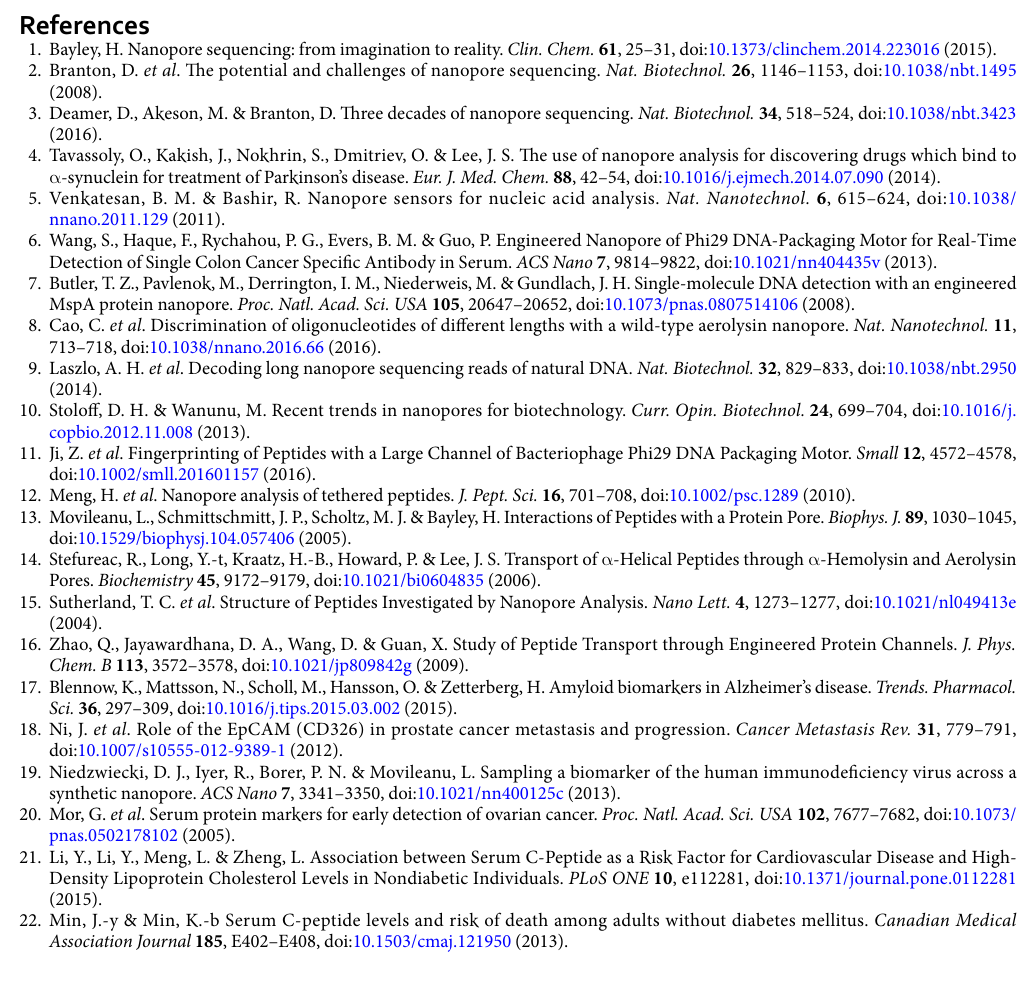
mobile phases consisted of solvent A (5% acetonitrile and 0.1% formic acid in water) and solvent B (0.1% formic acid in acetonitrile). The elution started at 0% B, held at this percentage for 9 minutes, increased to 25% B over 10 minutes, further increased to 60% B over an additional 11 minutes, and then was kept at this percentage for 21 minutes. The LC flow rate was maintained at 200 µ L min − 1 and the temperature of the column was maintained at 40 °C during the analysis. Mass spectrometry analysis was performed in positive ion mode with a spray voltage of 3000 V, an endplate offset of − 500 V, a nebulizer gas pressure of 1.5 bar, a dry gas flow rate of 8.0 l min − 1 , and a dry gas temperature of 200 °C.